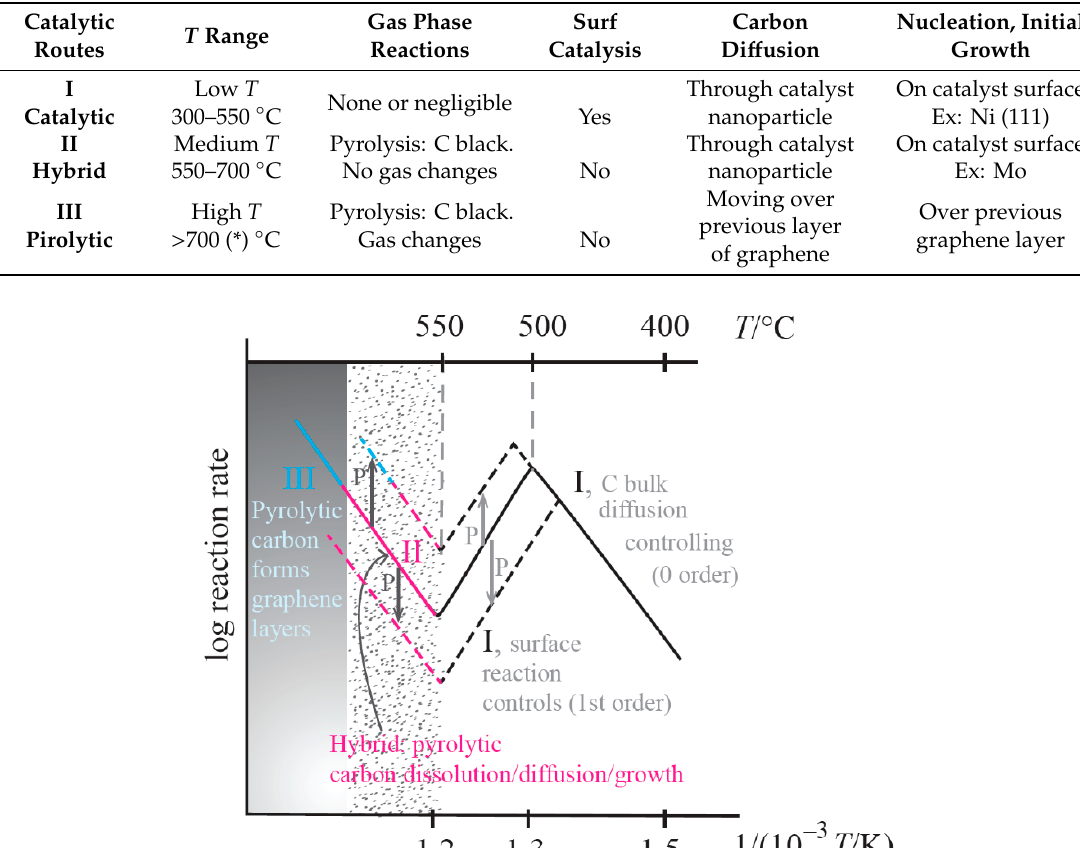
Table 1. Summary of the three different routes of graphene formation from hydrocarbons prevailing over different temperature ranges [1,2]; (*) 700–1100 °C.